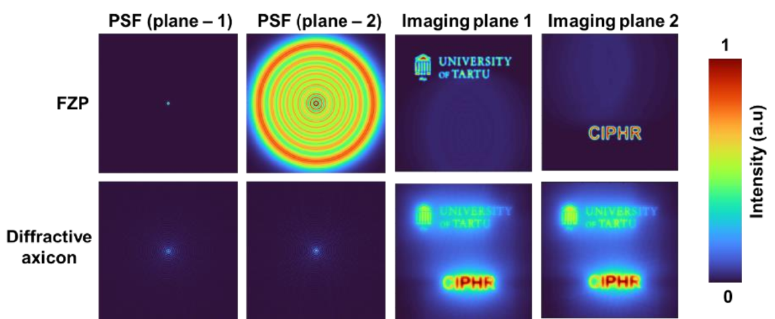
Figure 5. Images of PSFs and the imaging results of the two planes with two test objects for FZP and diffractive axicon.